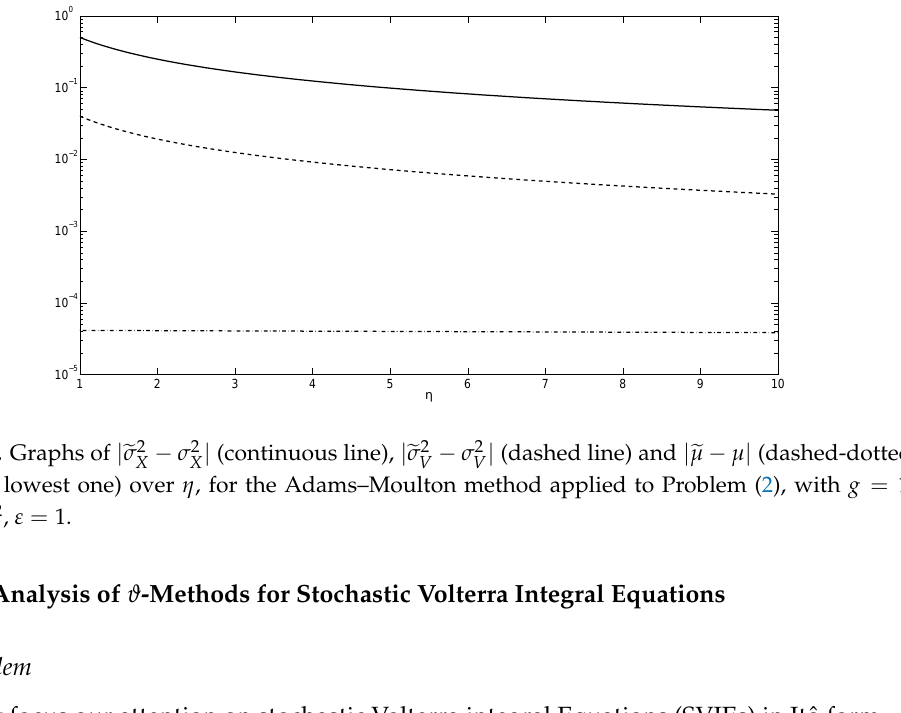
− σ 2 | (continuous line), | (cid:101) σ 2 X X